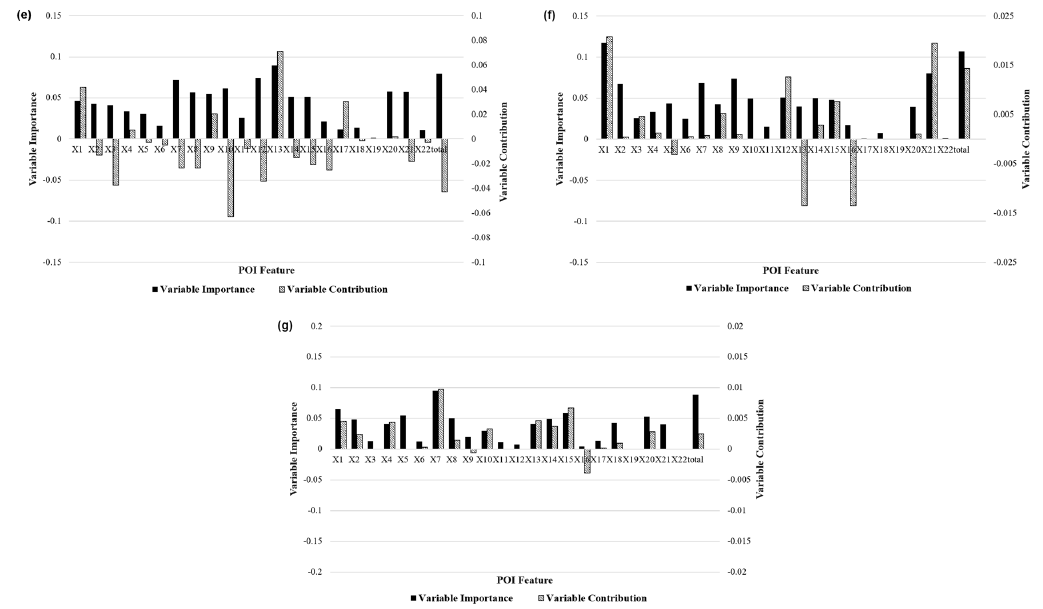
Figure 11. Driving mechanisms of the different travel patterns on weekdays: ( a – g ) the feature importance and feature contribution metrics of different POIs of mode1–mode7. POIs, Points of interest.